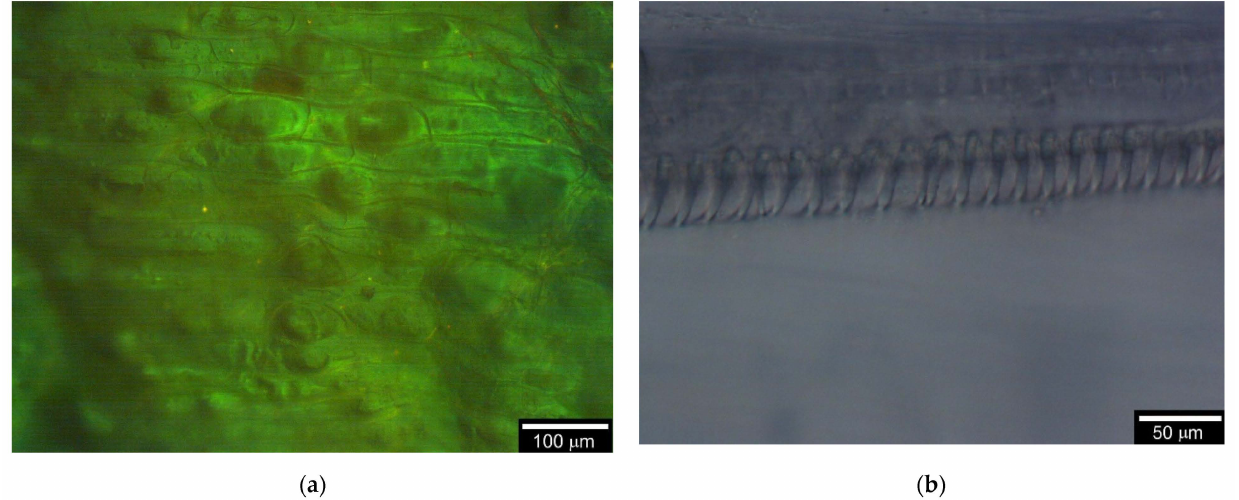
Figure 5. Optical microscopy images of sprout ( a ) the plant cells of sprout, ( b ) inside the cell wall, showing a helical structure.